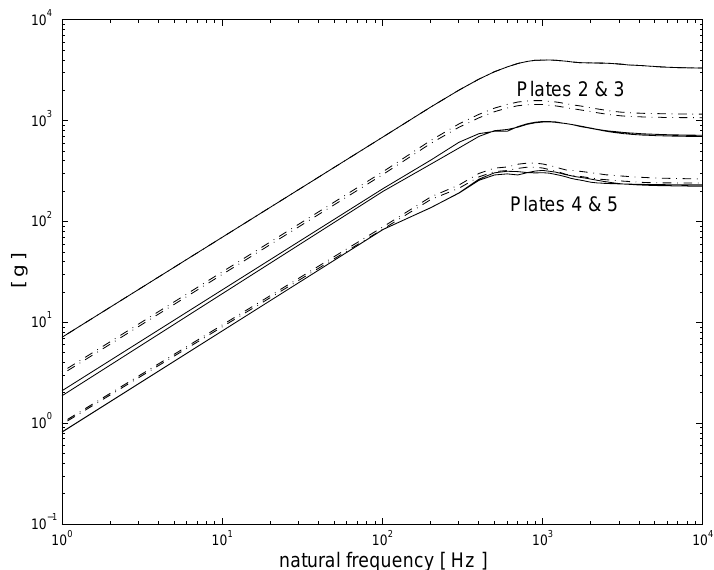
Fig. 10. SRS predicted by MSC-NASTRAN (continuous line) and by wave propagation analysis (dashed line) at several locations of the two-dimensional structure. the modal transient solution has been run. Results have been collected at a number of ‘control’ nodes located in the centers of the beams, as shown in Fig.